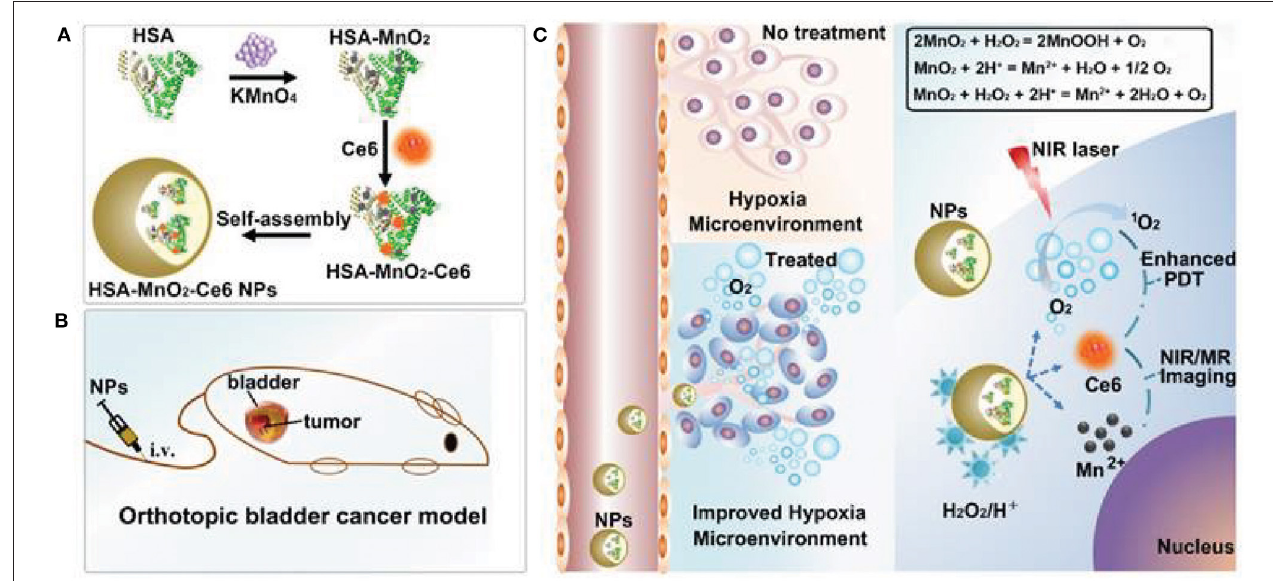
FIGURE 4 | Schematic representation of self-assembled MnO 2 nanoparticles modified with photosensitizer for photodynamic therapy (PDT) (A) . Application of MnO 2 nanoparticles catalyze endogenous peroxidase to oxygen and water and enhance the PDT efficacy upon laser exposure (B,C) . Reproduced with permission (Lin et al., 2018 ) under copyright Creative Commons Attribution 4.0 International License (CC-BY license)